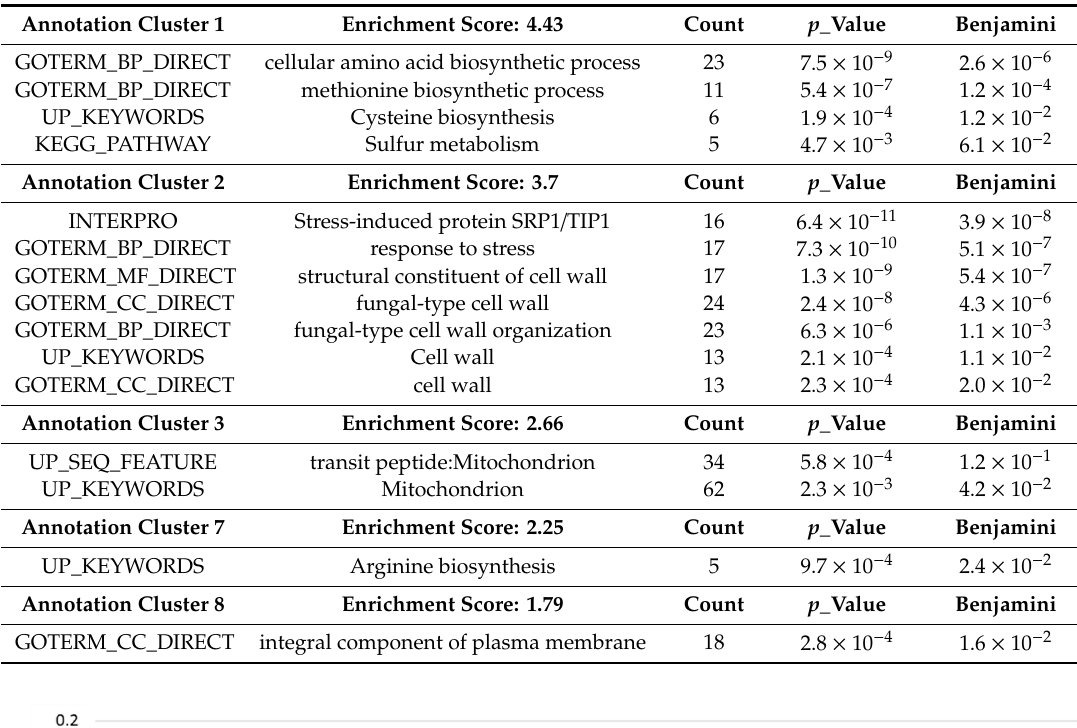
Table 4. Annotation clusters of ORFs di ff erentially expressed in M25 and EC1118 in response to fermentation in absence of oleic acid and ergosterol.